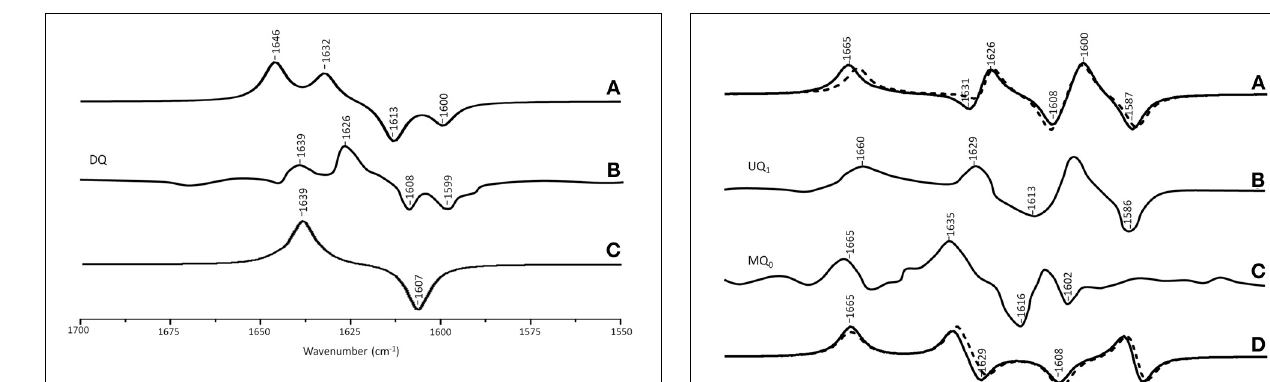
( Table 2 ). Upon 18 O labeling the C 1 = O and C 4 = O modes down- shift 35 and 40 cm − 1 , respectively ( Table 2 ). The mode intensities and composition are little altered by 18 O labeling. The C =